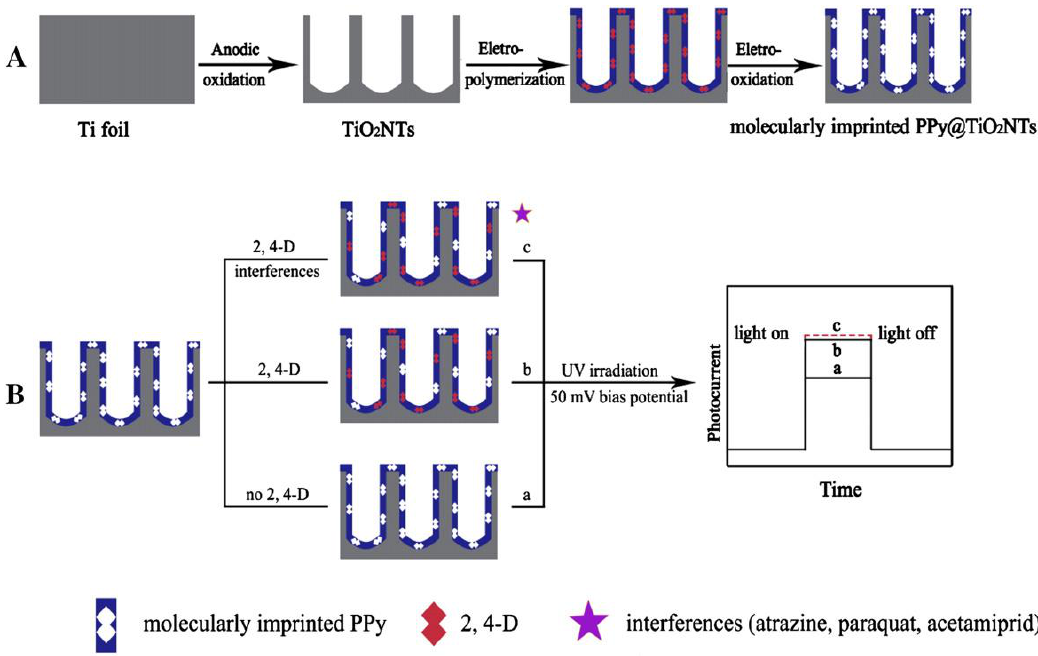
Figure 10. Schematic illustration for ( A ) fabrication and ( B ) detection mechanism of the photoelectrochemical sensor. Reprinted with permission from ref [102]. Copyright 2011 American sensor. Reprinted with permission from ref [102]. Copyright 2011 American Chemical Chemical Society.